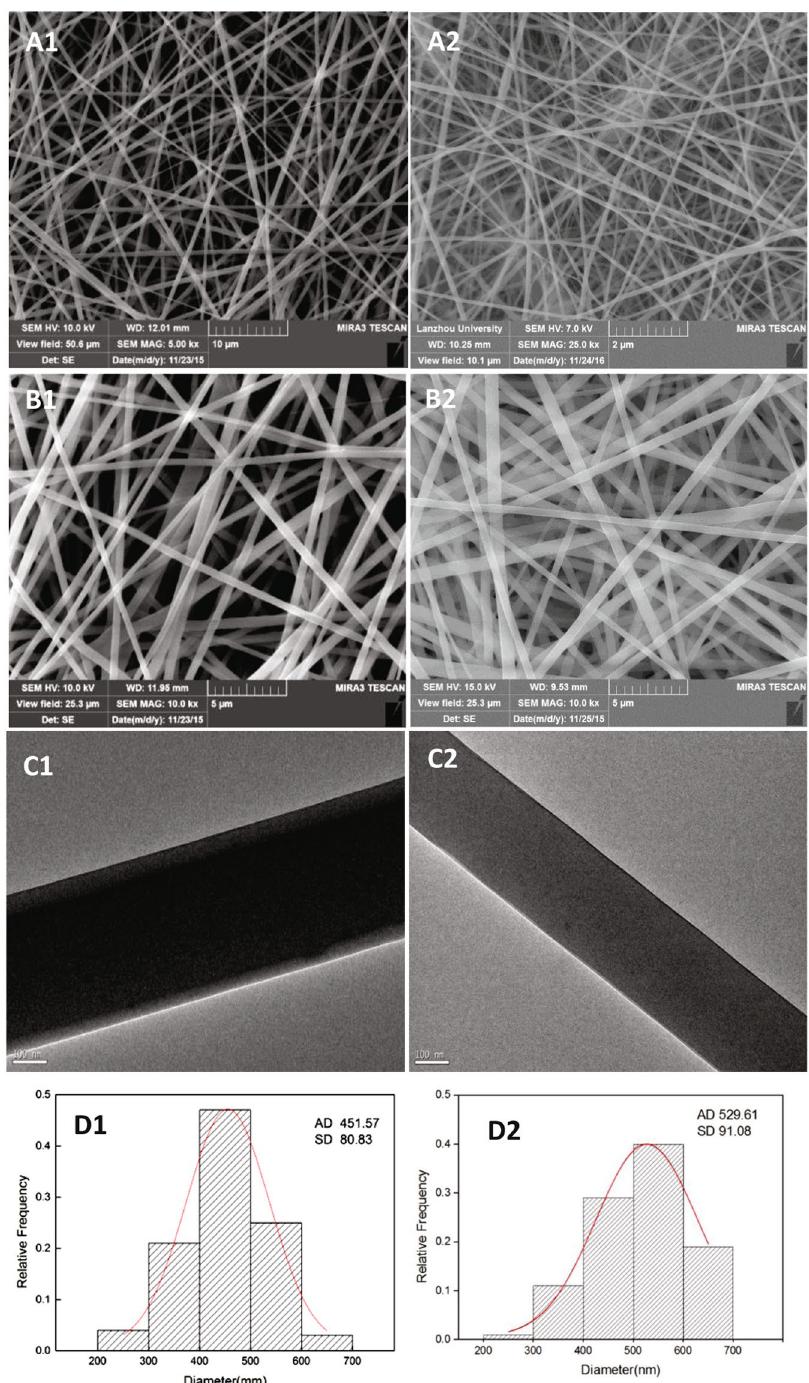
Figure 2. Representative SEM and TEM micrographs of the ICA-SF/PLCL and SF/PLCL nanofibrous membrane (scale bars: A1, 10 μ m; A2, 2 μ m; B1, B2, 5 μ m; C1,C2, 100 nm) and ( D ) the diameter distribution